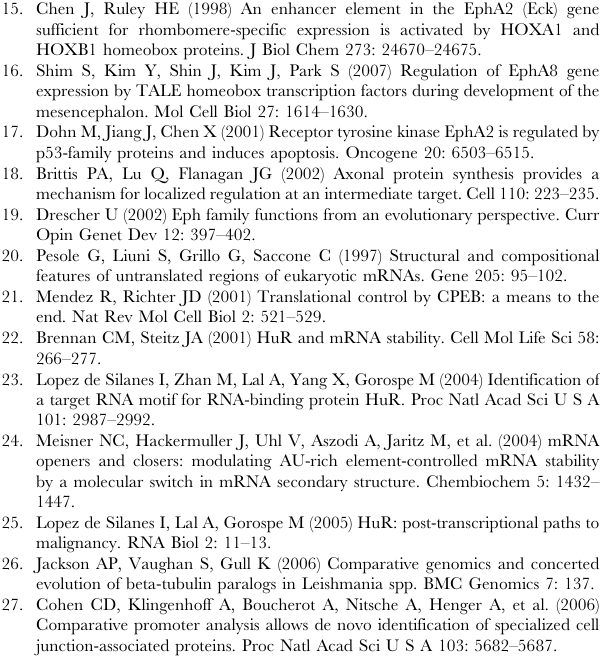
Figure S1 Secondary structures of Eph/ephrin 3’UTRs as predicted by Mfold. Shown are only those parts of the